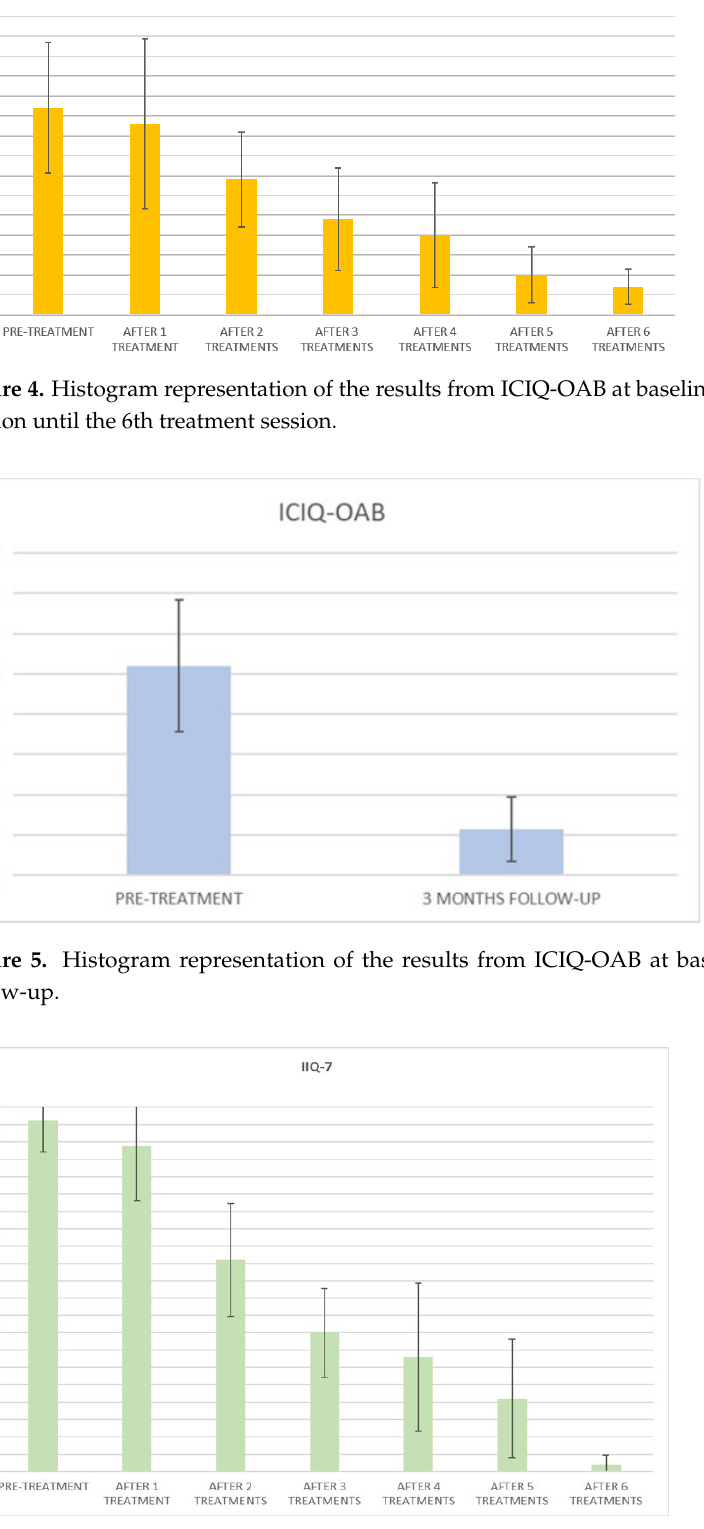
Figure 6. Histogram representation of the results from IIQ-7 at baseline and at each treatment session until the 6th treatment session.